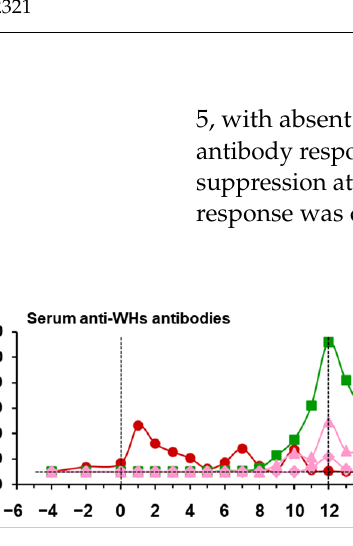
Figure 11. hzVSF treatment, alone and in combination with TAF, elicits antibodies to WHsAg and WHeAg in a subset of woodchucks. Changes in serum ( a ) anti-WHs antibody titers and ( b ) anti-WHe antibody levels in individual woodchucks during treatment with hzVSF at a low and intermediate dose (Groups 4–5) and TAF in combination with hzVSF at an intermediate dose (Group 8) relative to the pretreatment baseline (T0). The horizontal dotted lines indicate the detection limit for anti-WHs antibodies (i.e., 100 StdU/mL) or serum presence of anti-WHe antibodies (i.e., 2.52 ODU for F1806 and M1821 and 2.19 ODU for F1823). Abbreviations: StdU, standard unit; ODU, optical density